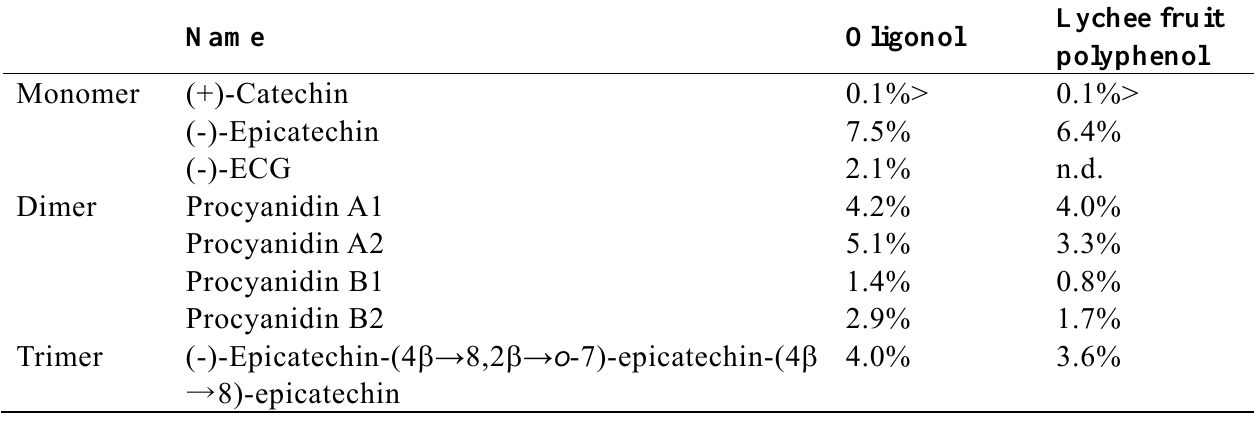
Table 1. Composition of oligonol and lychee fruit